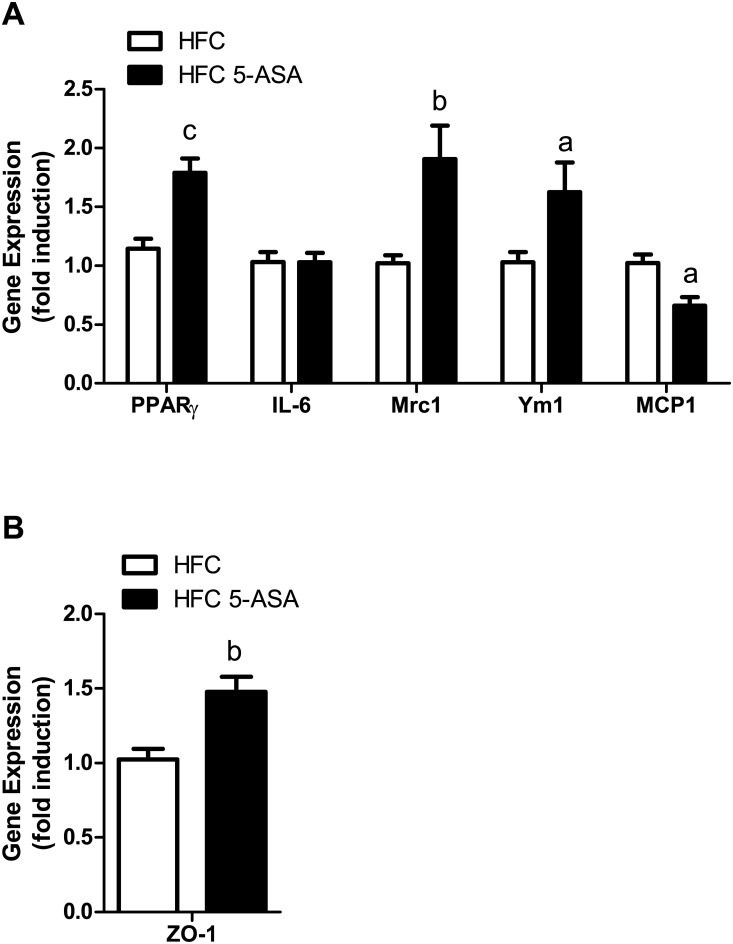
Effects of 5-ASA intervention on inflammation and tight junction of the small intestine.(A) qPCR analysis of small intestinal lysates for gene expression of PPARγ, IL-6, Mrc1, Ym1 and MCP1. (B) qPCR analysis of small intestinal lysates for gene expression of ZO-1. Data are presented as means ± SEM, n = 9–10 mice, aP < 0.05 vs. HFC, bP < 0.01 vs. HFC, cP < 0.001 vs. HFC.